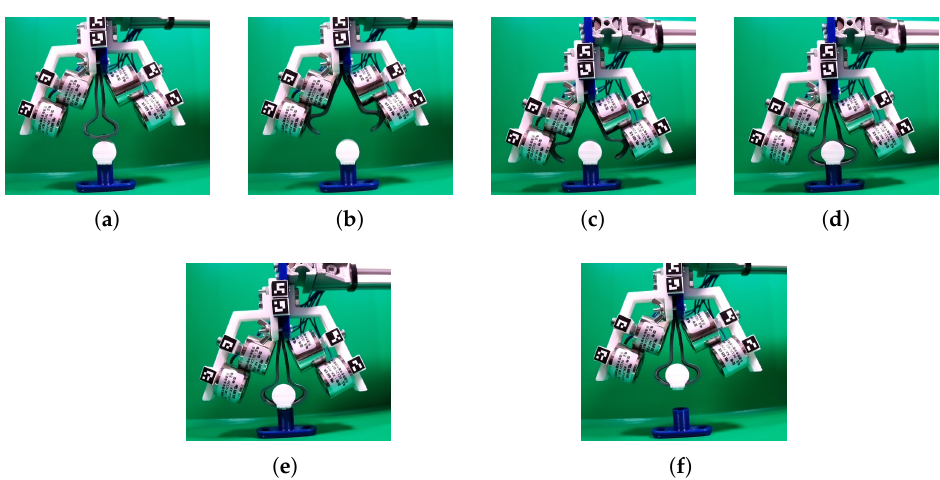
Figure 12. Gripper positions during weight lift experiment. Base position, closed gripper ( a ). Base position, opened gripper ( b ). Catching position, opened gripper ( c ). Catching position, closed gripper ( d ). Initial lifting position, closed gripper ( e ). Goal lifting position, closed gripper ( f ).